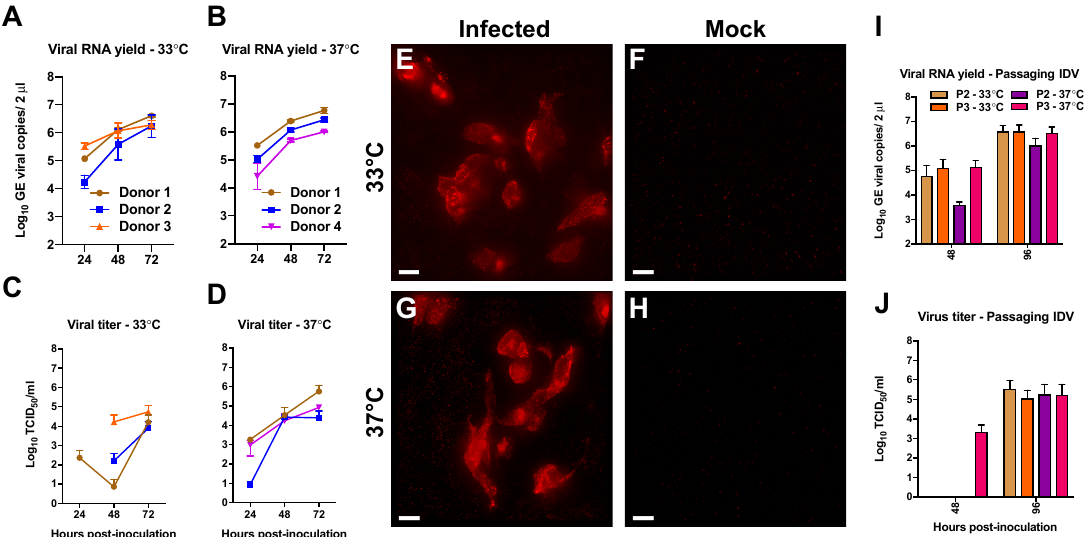
Figure 1. E ffi cient replication of Influenza D virus (IDV) in well-di ff erentiated human airway epithelial cell (hAEC) cultures. Human airway epithelial cell cultures were inoculated with 10,000 tissue culture infectious dosis 50 (TCID 50 ) of IDV and incubated at either 33 ◦ C or 37 ◦ C. The monitored viral RNA yield is given as genomic equivalents (GE) per 2 µ L of isolated RNA ( y -axis) at indicated hours post-inoculation ( x -axis) for 33 ◦ C ( A ) and 37 ◦ C ( B ). Whereas the viral titer is given as TCID 50 / mL ( y -axis) for 33 ◦ C ( C ) and 37 ◦ C ( D ) at indicated hours post-inoculation ( x -axis). These results are displayed as means and standard deviation (SD) from duplicates from three independent donors. Human airway epithelial cell cultures were formalin-fixed and immunostained with a custom generated antibody against the nucleoprotein (NP) of Influenza D virus to detect viral antigen. A representative image from one of the three independent donors is shown for IDV infection at 33 ◦ C and 37 ◦ C ( E , G ) as well as their respective controls ( F , H ). Magnification 60 × , the scale bar represents 10 micrometers. To assess if IDV viral progeny is infectious, hAEC cultures were inoculated with tenfold-diluted apical wash of passage 1 virus that was serial-passaged, for two consecutive passages, upon naïve hAEC cultures. The monitored viral RNA yield is given as genomic equivalents (GE) per 2 µ L of isolated RNA ( y -axis) at indicated hours post-inoculation ( x -axis) for each of the conditions ( I ). Whereas the viral titer is given as TCID 50 / mL ( y -axis) for each condition, at indicated hours post-inoculation ( x -axis) ( J ). The results are displayed as means and SD from duplicates from three independent donors.